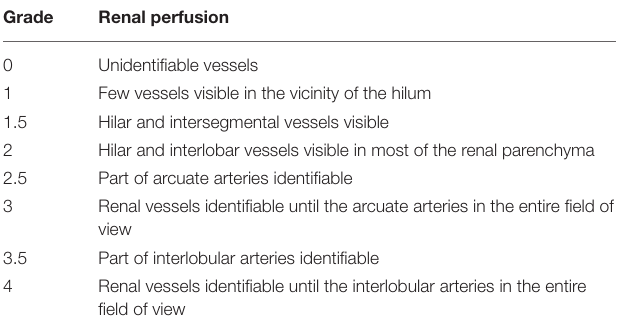
TABLE 1 | Modified semi-quantitative PDU score for evaluating renal